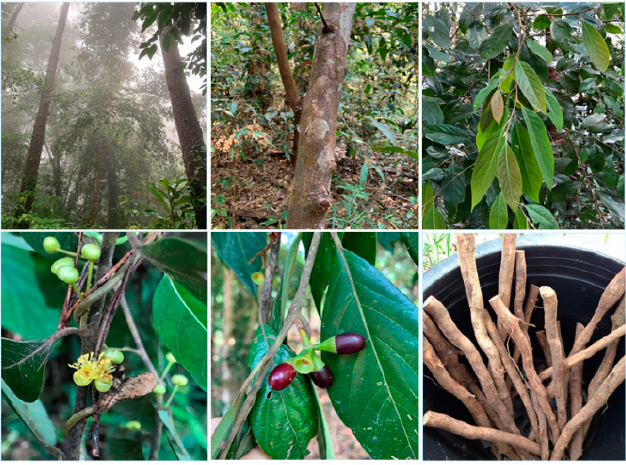
Figure 1. Litsea martabanica (Kurz) Hook.f.